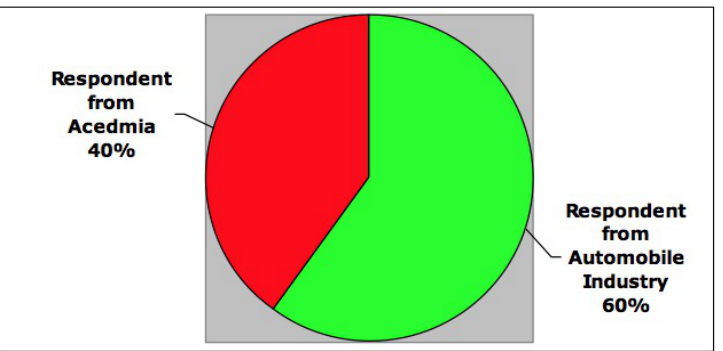
Figure 2. Respondent from Industries and Academics considered for the